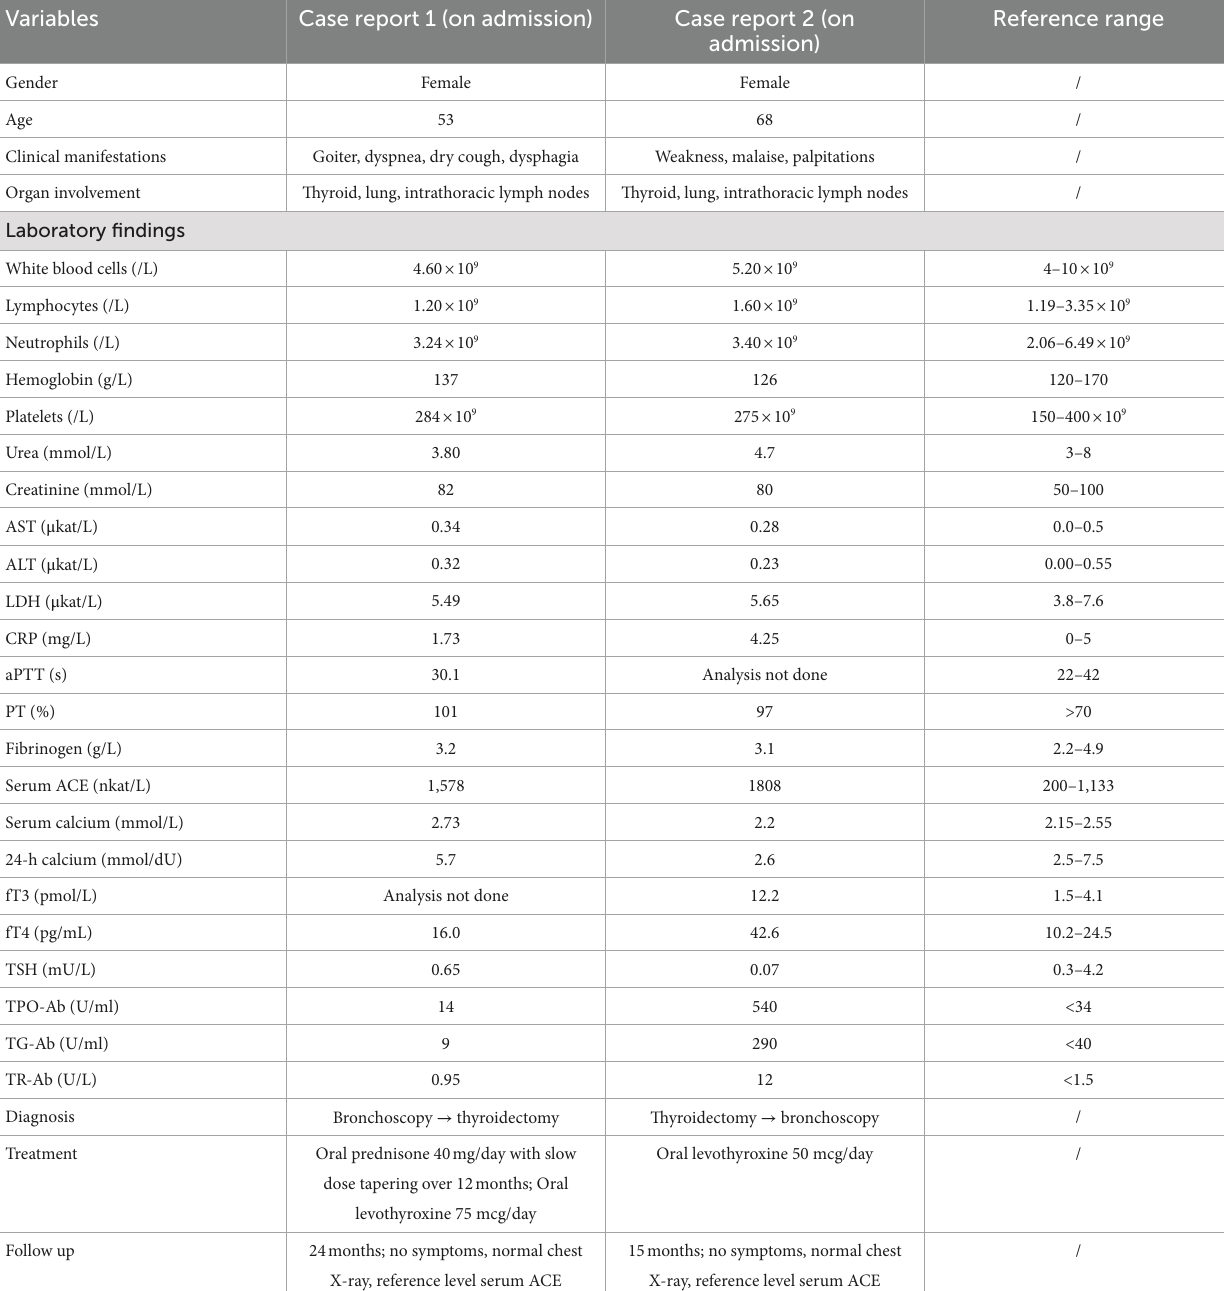
TABLE 1 Main socio-demographic, clinical and laboratory data from two reported